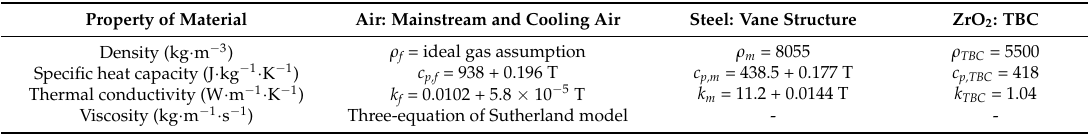
Table 2. Properties of air, steel [28,29] and TBC.